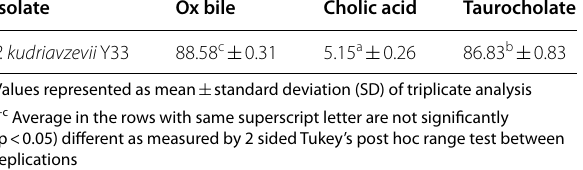
Table 5 Cholesterol assimilation (%) of P. kudriavzevii Y33 in different bile salts